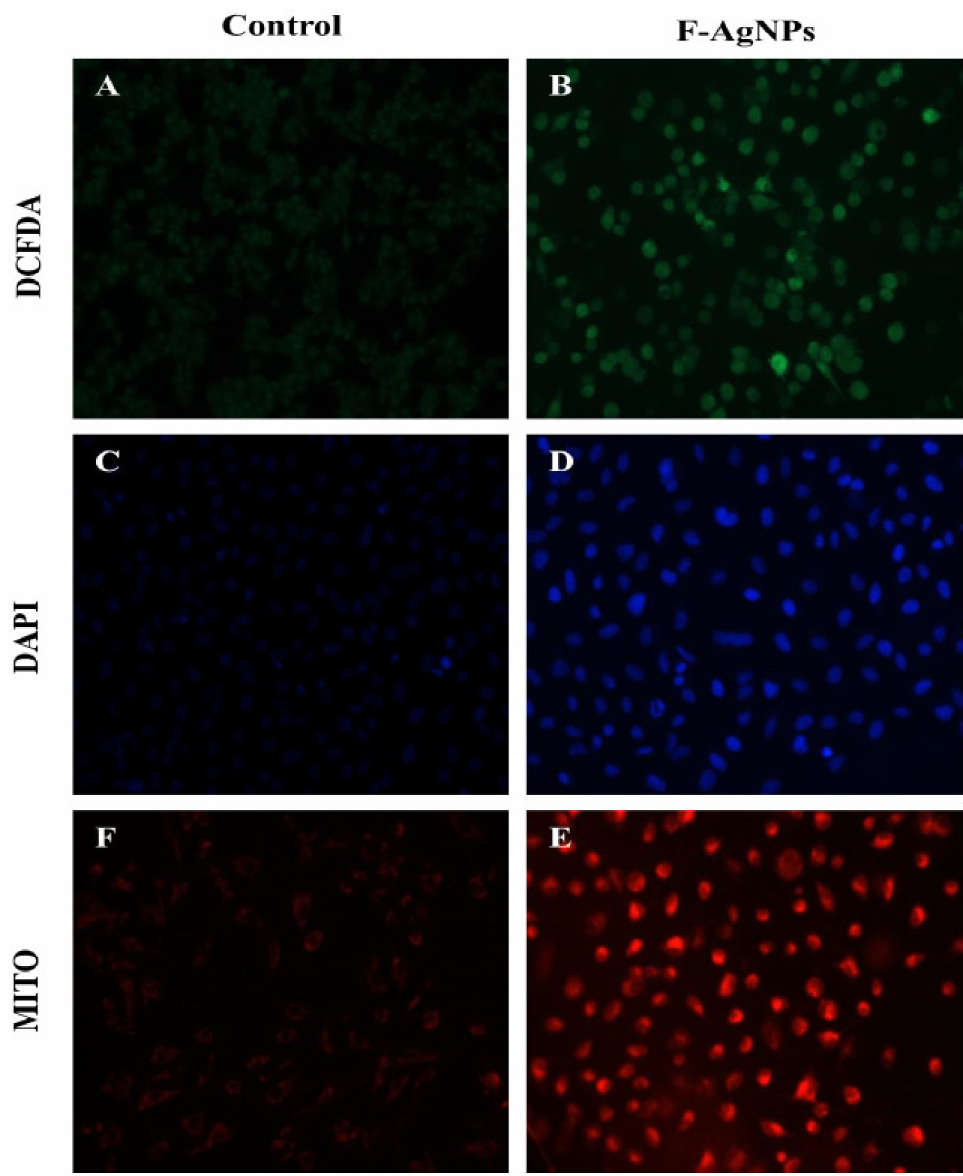
Figure 6. Image showing the effects of F-AgNP treatement on A549 cells at 20 × magnification with ROS staining: ( A ) control and ( B ) IC-50; DAPI staining: ( C ) control and ( D ) IC-50; and Mito Tracker Red: ( E ) control and ( F )